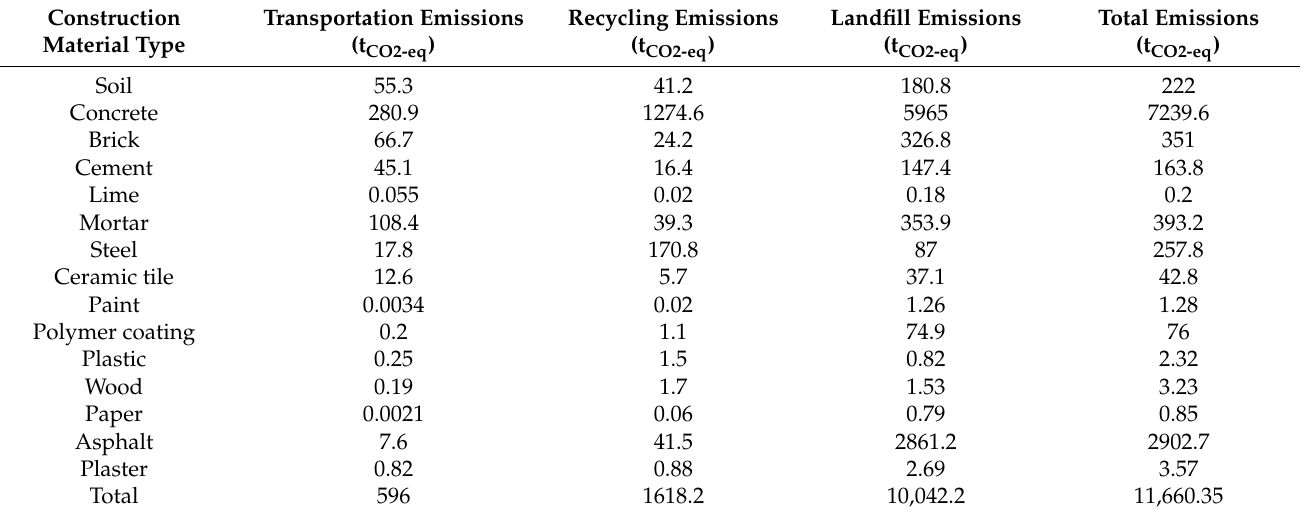
Table 4. CO 2 emissions in C&D waste in China